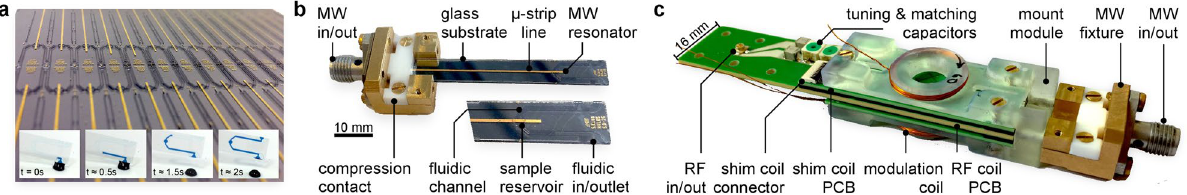
Figure 6. ( a ) Photograph of a bonded wafer stack featuring 30 individual microstrip resonators. The insets demonstrate the loading of aqueous sample (colored by blue pigments) via capillary forces. ( b ) Fabricated MW fixture, equipped with a resonator chip. ( c ) Fabricated ODNP probe head, shown with the MW microfluidic chip being inserted into the stacked figure-8 NMR transceive coil. Figure used with permission 41